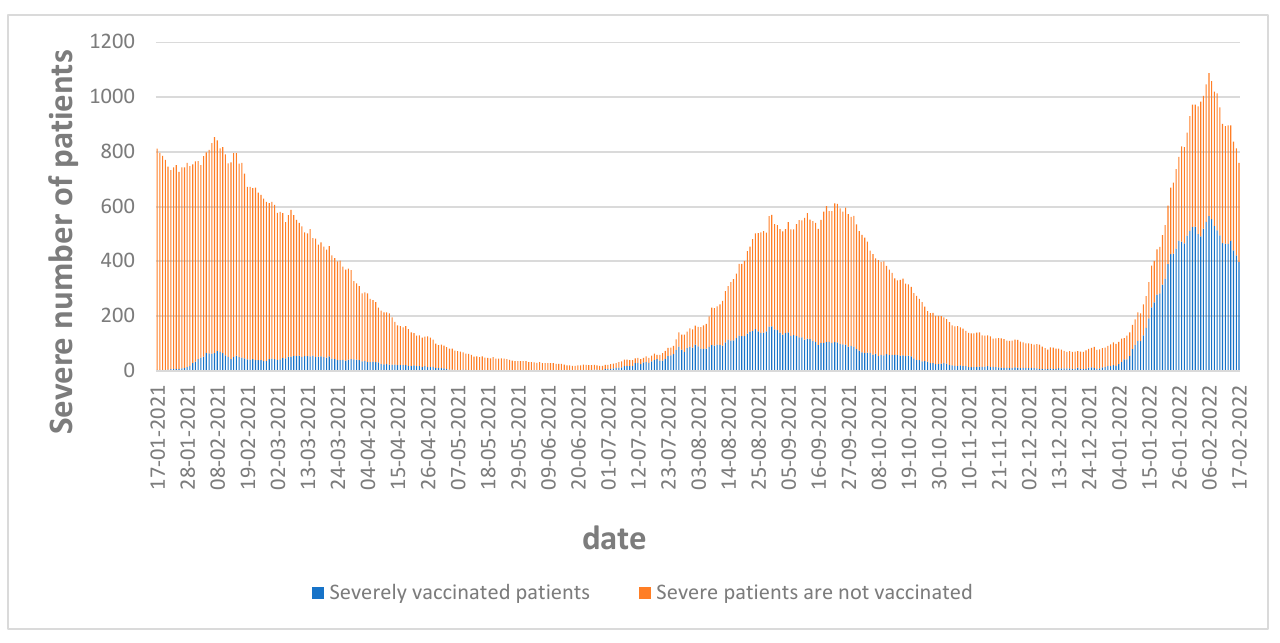
Severely vaccinated patients Severe patients are not vaccinated Figure 3. Severely ill vaccinated versus unvaccinated people. Figure 3. Severely ill vaccinated versus unvaccinated people.